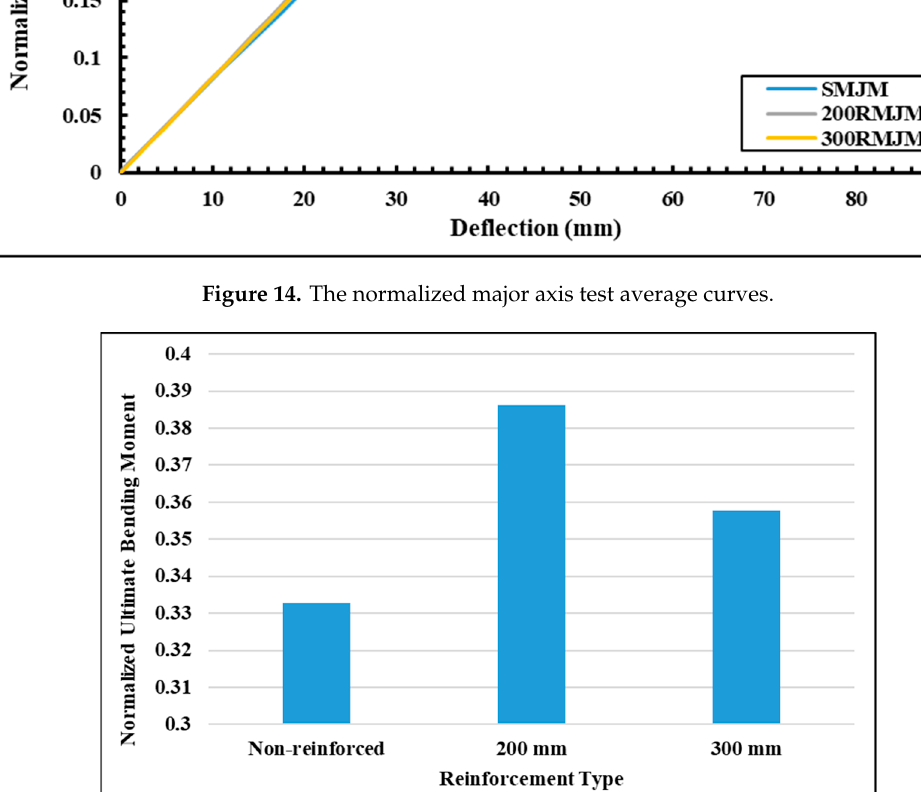
Figure 14. The normalized major axis test average curves.